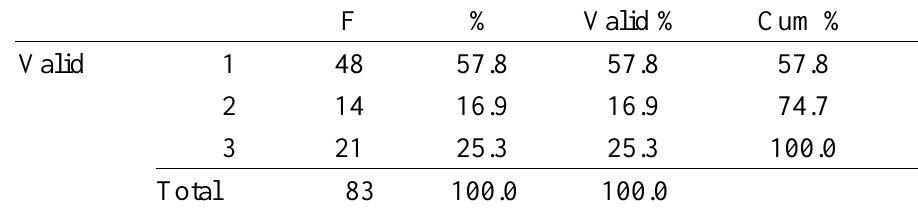
Tabel 8 . P7. Peniruan Konten (Verbal and